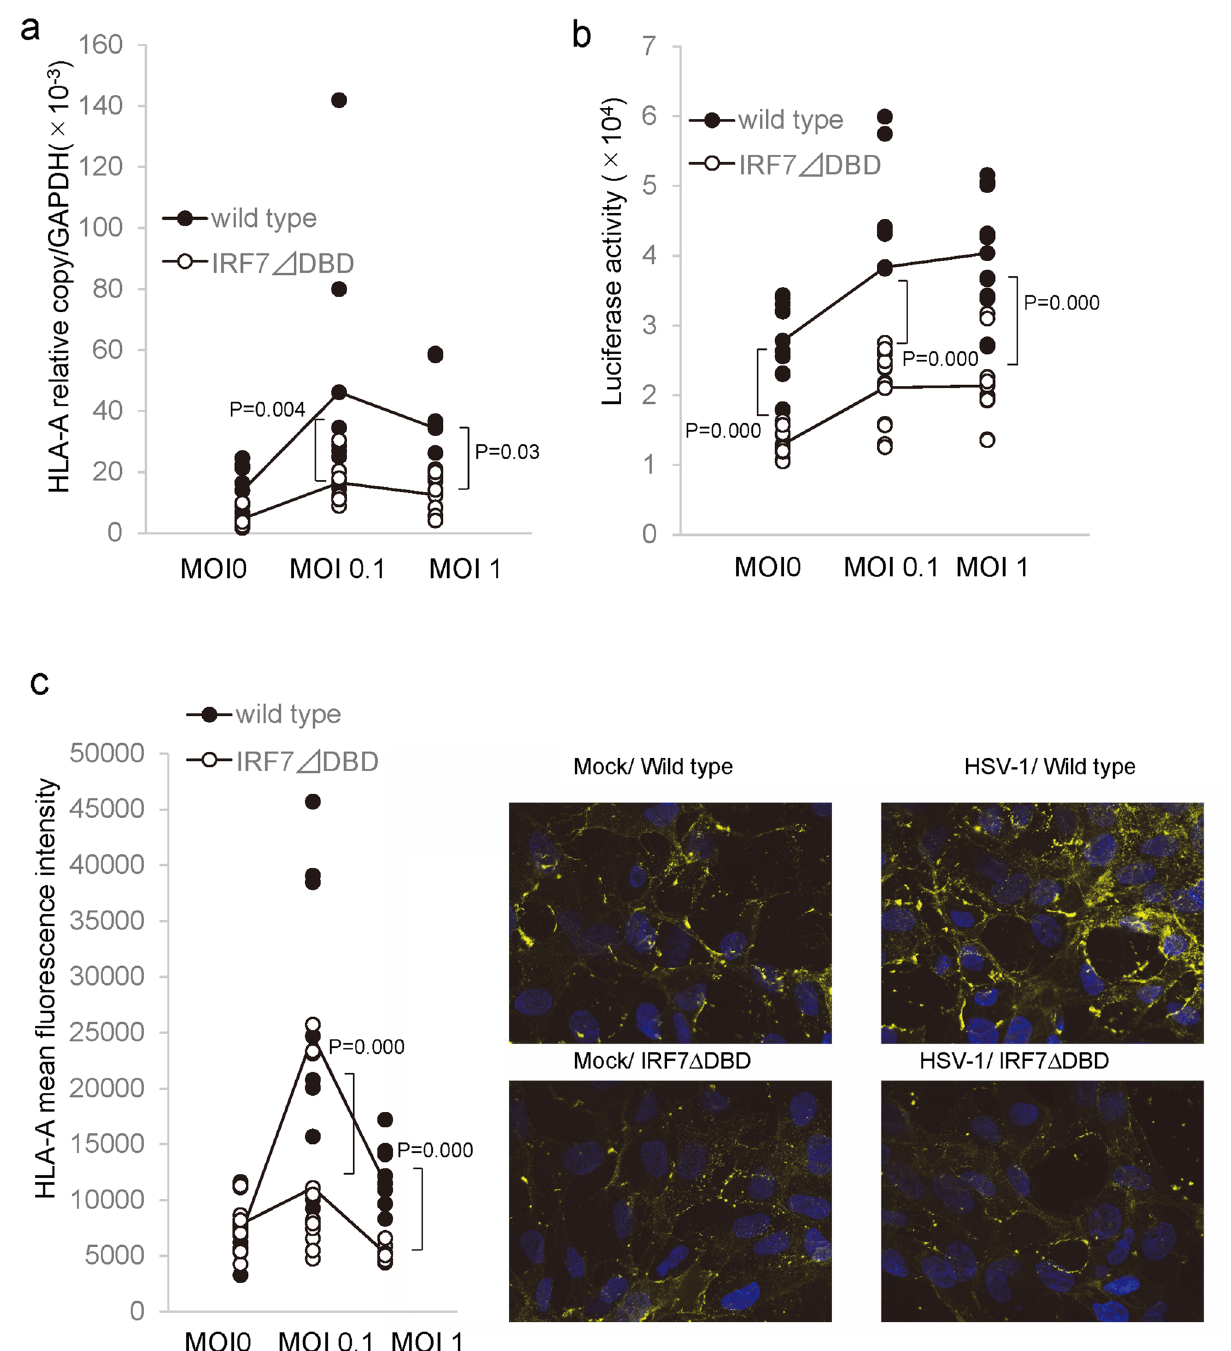
Figure 5. IRF7-dependent MHC class I induction after HSV-1 infection. ( a ) Induction of HLA-A mRNA is significantly reduced in IRF7 ∆DBD cells compared to wild type at 12 h PI. N = 8, ANOVA Tukey test. ( b ) HLA-A2402 promoter reporter vector was transfected into HCEn cells, and the reporter activity after infection was measured using luciferase activity. N = 12, ANOVA and Tukey test. ( c ) Upregulation of HLA-A expression in HCEn cells after HSV-1 infection (12 h PI) by immunohistochemistry (MOI 1). HSV-1-infection-induced HLA-A expression is reduced for IRF7 ∆DBD cells at MOI 0.1 and MOI 1. The signal intensity of HLA-A expression was assessed for 25,000 cells in 14 high powered fields/group. Cells were analyzed using hybrid cell count software (BZ-H4C, Keyence, Osaka, Japan, https:// www. keyen ce. com/ ss/ produ cts/ micro scope/ bz- cases tudy/? tag_ tips= Medic al% 20/% 20Life% 20Sci